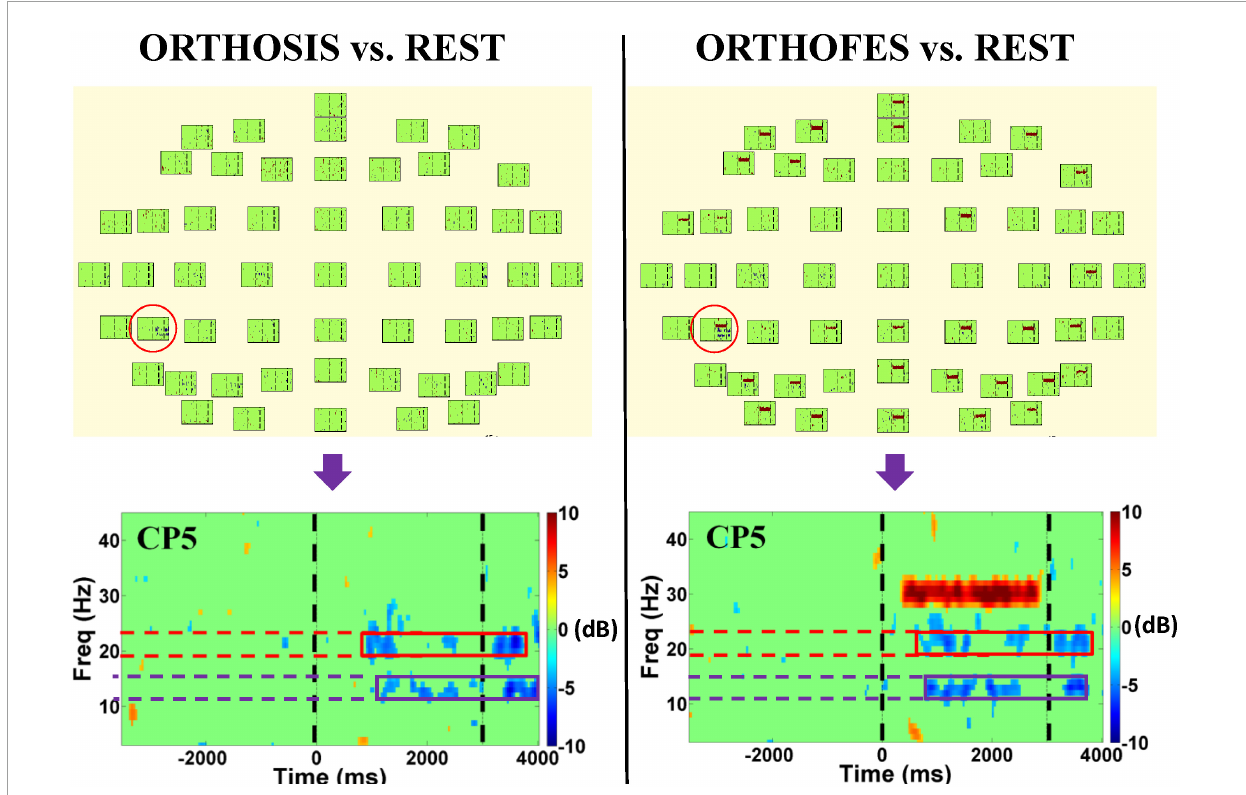
FIGURE2 EEG spectral power bootstrap analysis during passive right-hand movement in one representative participant. The left and right panels show the differences in the time-frequency domain when ORTHOSIS and ORTHOFES conditions were compared to REST, respectively. CP5 was selected as a representative electrode (red circle) after visual inspection due to its more salient power suppression compared to other electrodes. The figures at the bottom show the enlarged plot of the selected electrode. The purple and red boxes indicate the frequency bands in which we found more significant power changes when using the bootstrap analysis. The green areas indicate no significant power differences compared to REST conditions. The color represents the power suppression, power enhancement, or no differences compared to the REST condition: blue being power suppression in dB, red being power enhancement in dB, and green being not significantly different ( P < 0.01) from REST. The two black dashed vertical lines indicate the beginning (0 ms) and end of the passive movement during a trial (3,000 ms). The high spectral power in the range of 30 Hz was observed in the right panel during the trial period due to FES (stimulation frequency: 30 Hz) artifact, which was not found in ORTHOSIS (left